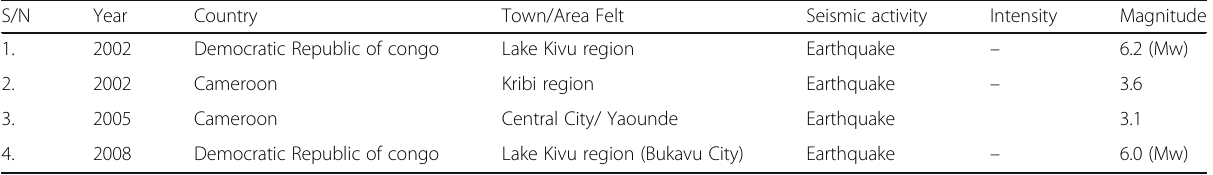
Table 3 Seismic occurrences, location, year, magnitude and intensity in Central Africa